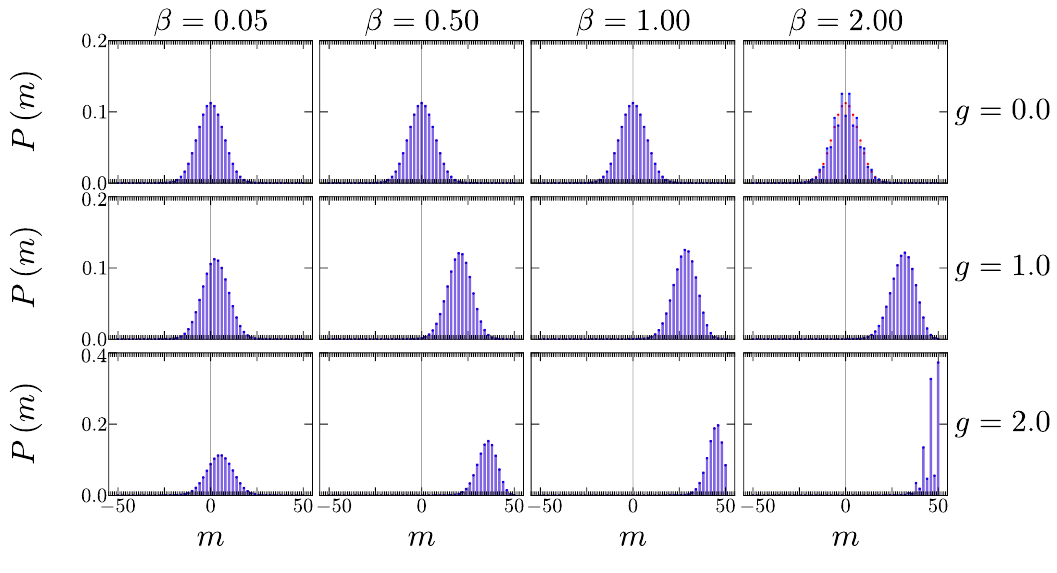
Figure 8: Magnetization distribution at thermodynamic equilibrium. Probability distribution of the transverse magnetization P ( m ) for different values of the magnetic field g and inverse temperature β in a chain of L = 50 spins. The exact probabil- ity distribution Eq. (101) (red bars) is compared with the simplified expression in Eq. (105) (blue